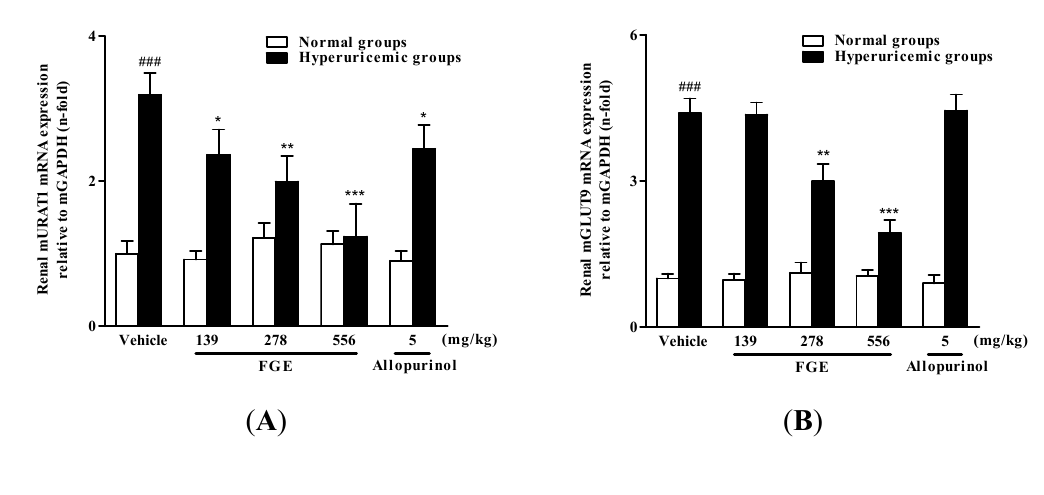
Figure 1. Effects of FGE and allopurinol on mRNA and protein levels of renal urate transport-related transporters in hyperuricemic and normal mice. Kidney cortex mRNA was extracted for RT-PCR analysis of mURAT1 ( A ), mGLUT9 ( B ), mABCG2 ( C ), mOAT1 ( D ) and mOAT3 ( E ). Kidney cortex tissues were used for western blot analysis of mURAT1, mABCG2, mGLUT9, mOAT1 and mOAT3 ( F ). The ratio of mURAT1 ( G ), mABCG2 ( H ), mGLUT9 ( I ) mOAT1 ( J ) and mOAT3 ( K ) density to α -tubulin density. Data were expressed as the mean ± S.E.M. for 4 mice. ## p < 0.01, ### p < 0.001, compared with normal vehicle animals. * p < 0.05, ** p < 0.01, *** p < 0.001, compared with hyperuricemia vehicle